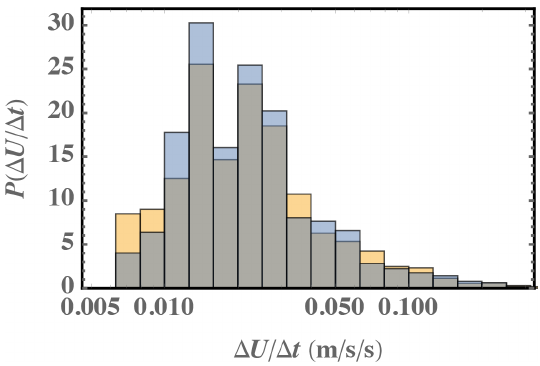
Figure 2. Probability density function of (mean) ramp accel- erations, with logarithmic axis for (cid:49)U/(cid:49)t . Yellow: all events; blue: excluding events which exceed cutout or start above rated speed (as in Fig. 1); gray: overlap of